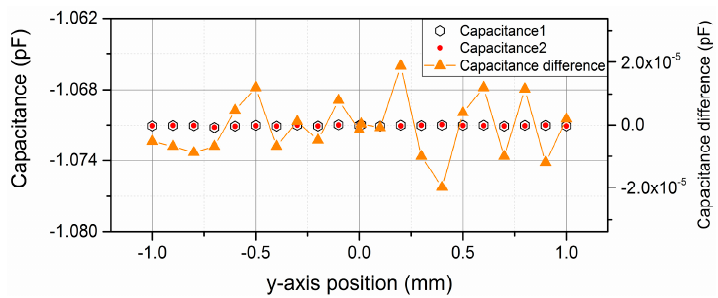
Figure 4. Simulation result of differential capacitance value over the range of ±1 mm along the y-axis.